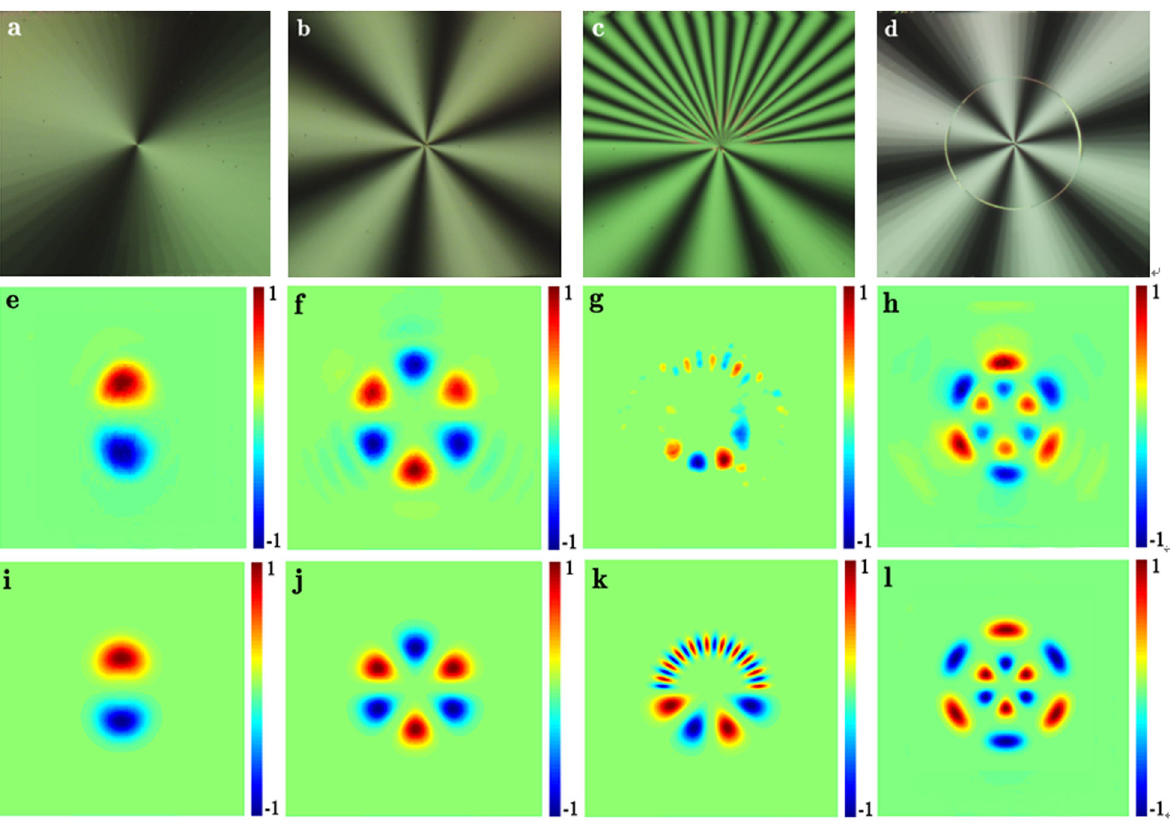
Fig. 3 Micrographs of four representative samples with the distribution functions of optical axis as a α 1 ( r, φ ) = 0.5 φ , b α 2 ( r, φ ) = 1.5 φ , c α 3 ( r, φ ) r, φ ) = 1.5 φ + 0.5 π ·H ( r − r e – h ) = 2 φ ·H ( φ − π ) H (2 π − φ ) + 10 φ ·H ( φ ) H ( π − φ ), and d α 4 ( 0 ), respectively. It is obvious that the measured PSHE patterns ( are in excellent agreement with theoretical simulations ( i – k ). For α 1 ( r, φ ) and α 2 ( r, φ ), the number of splitting states is equal to 4 q ( q = 0.5 or 1.5), and these states locate along the azimuthal direction regularly. In the case of α 3 ( r, φ ), twenty states are on the upper half plane while four ones are on the lower half. If an additional circular discontinuity is introduced in as α 4 ( r, φ ), there are both six states locate within and outside of the circle . The two states in one radial orientation correspond to the σ + and σ - components,